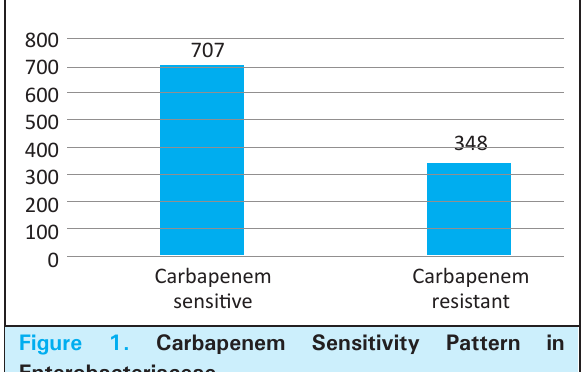
Carbapenem Figure 1. Carbapenem Sensitivity Pattern in Enterobacteriaceae.